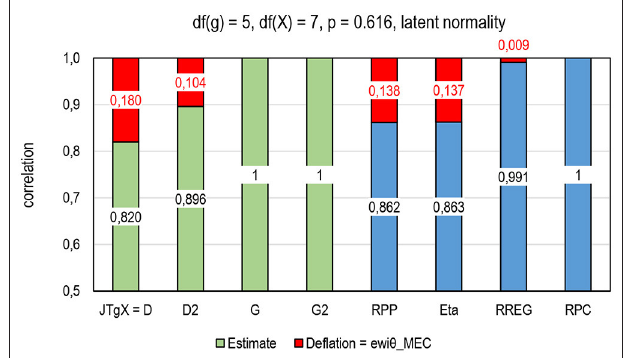
FIGURE 11 | Deflation in the estimates in an item with p = 0.616, df(g) = 4, and df(X) = 7, latent normality, n =